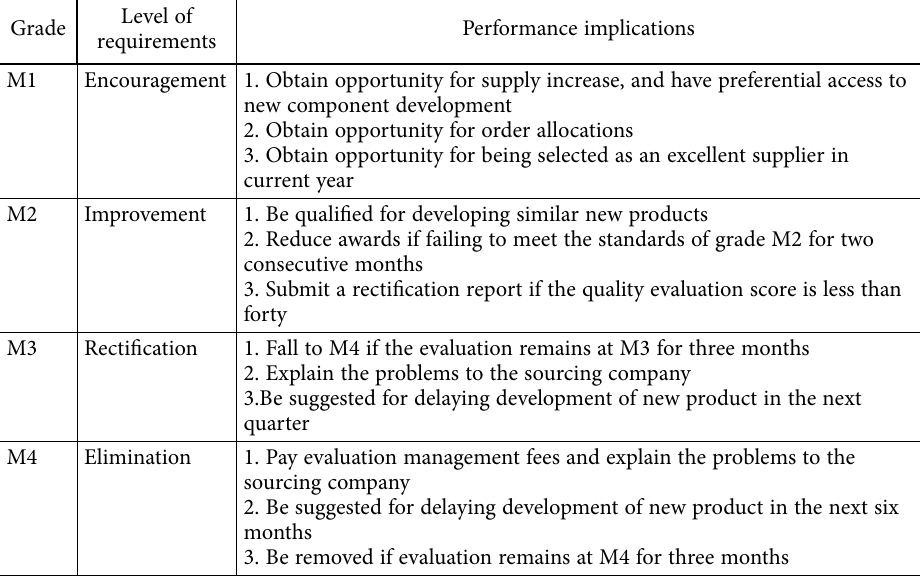
Performance implications